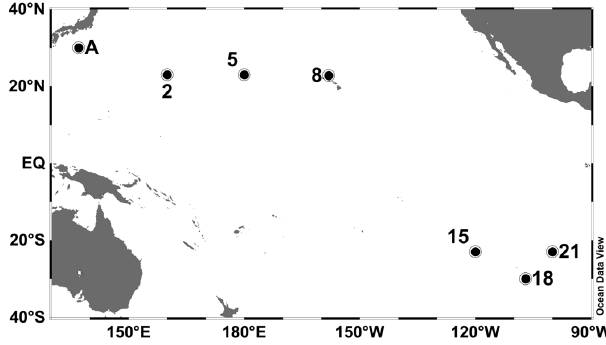
Figure 1. Study areas and sampling stations in the subtropical Pacific Ocean. Station A was occupied in July 2010 during the R/V Tansei Maru KT-10-13 cruise. Stations 2–21 were occupied for the period from December 2011 to January 2012 during the R/V Hakuho Maru KH-11-10